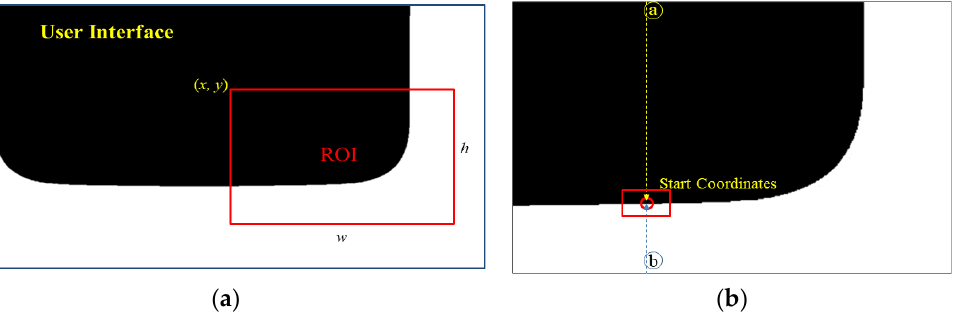
Figure 8. Preprocessing steps. ( a ) Setting the ROI. ( b ) Starting point search ( ⓐ : search position of point A, ⓑ : search position of point B).